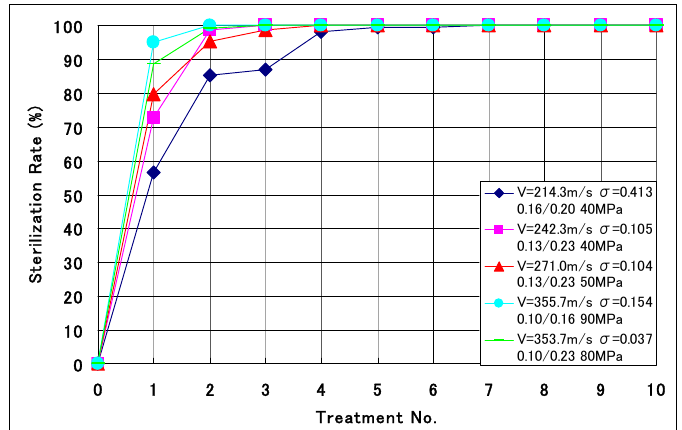
Fig. 8. Sterilization rate vs number of passes for E. coli